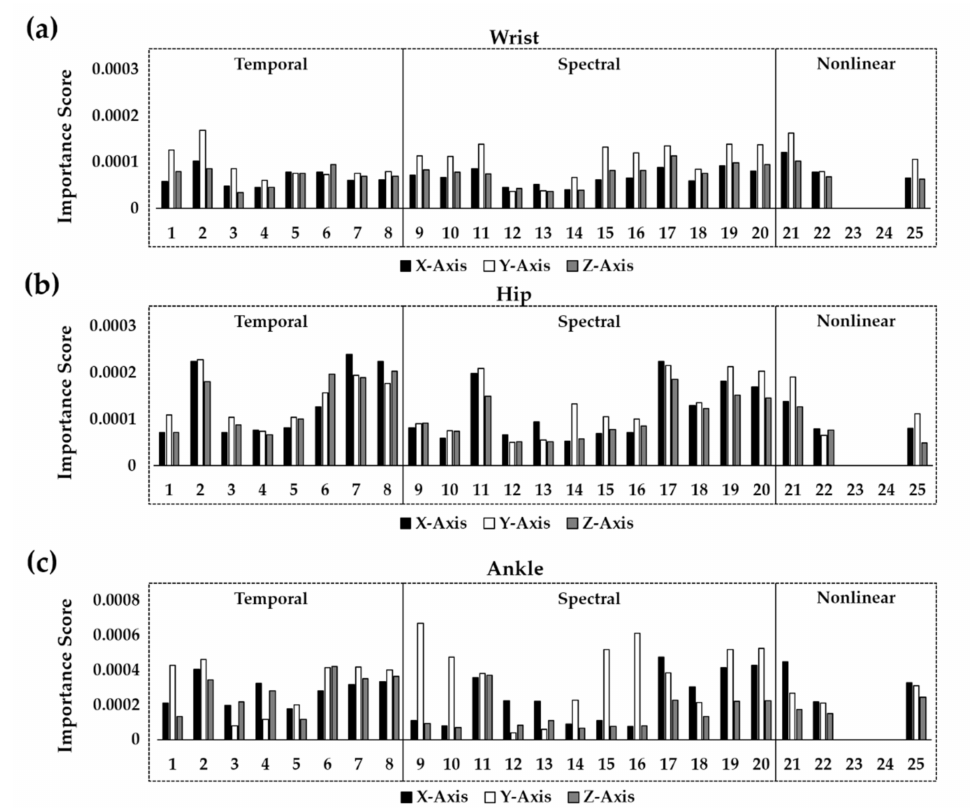
Figure 9. Feature importance of RF binary-class classification depending on the sensor location: ( a ) wrist-worn sensor, ( b ) hip-worn sensor, and ( c ) ankle-worn sensor. The indices in the horizontal line indicate (1) RMS, (2) σ , (3) skewness, (4) kurtosis, (5) the number of ZC, (6) PTP, (7) Hjorth mobility, (8) Hjorth complexity, (9–11) three PPs, (12–14) three DFs, (15) TE, (16) SpecEn, (17–20)